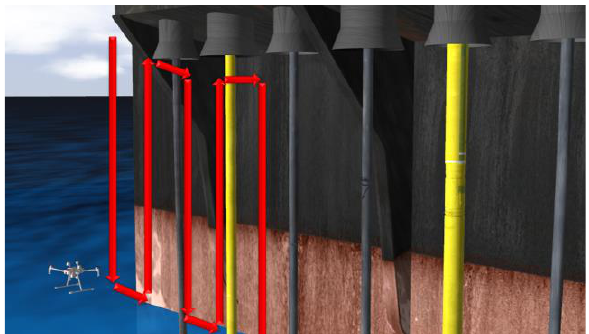
Figure 5. Virtual environment containing the M210 RPA, riser balcony and the serpentine trajectory (in red) for inspection process.